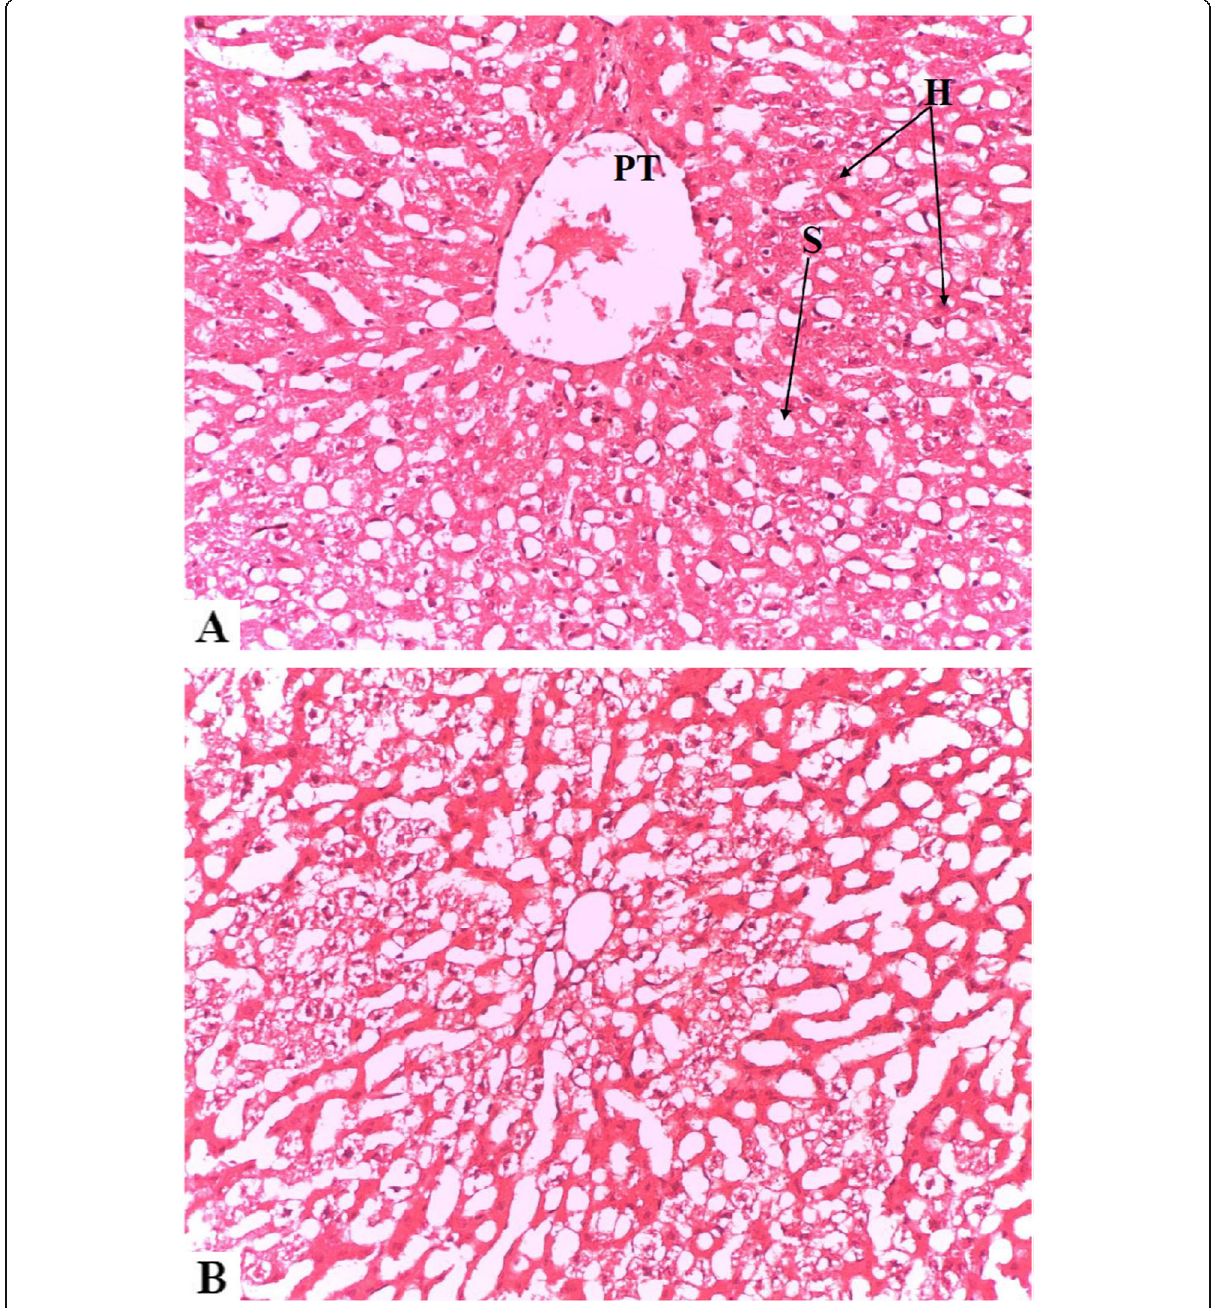
Fig. 6 Photomicrographs of liver section of rat administered ethanolic leaves ’ extract of P. guineense (100 mg/kg bw) showing normal sinusoids (S) and hepatocytes (H). Portal tract (PT) appeared